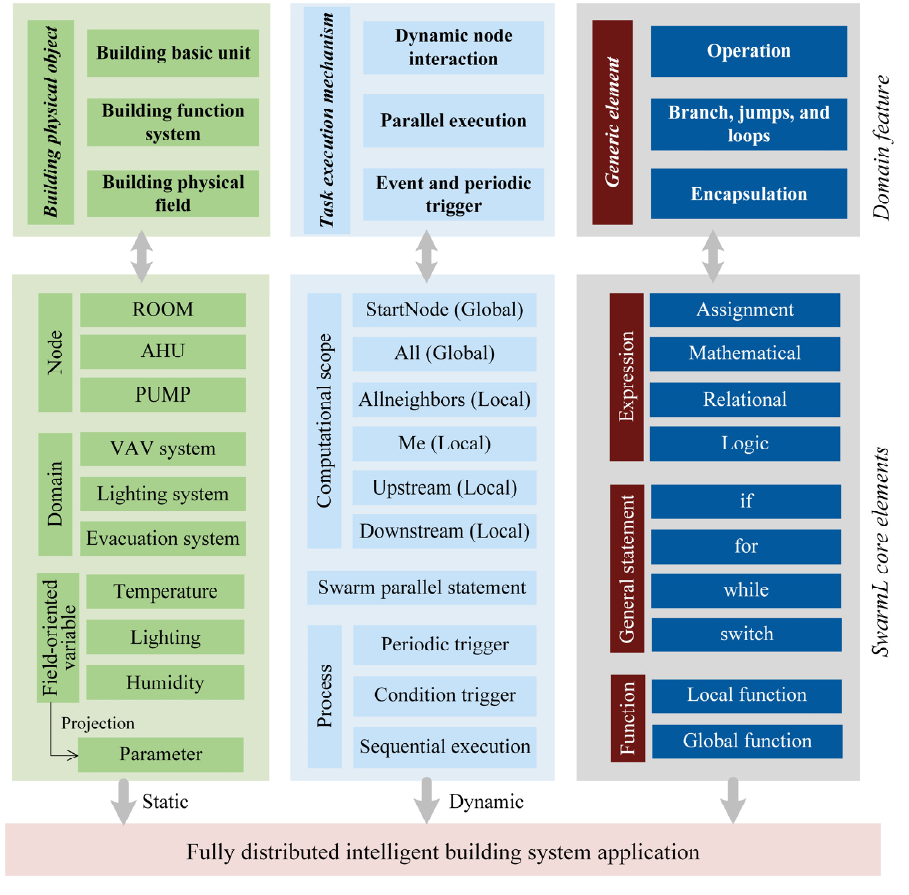
Figure 5. Overall framework of SwarmL. Table 1. Data types of